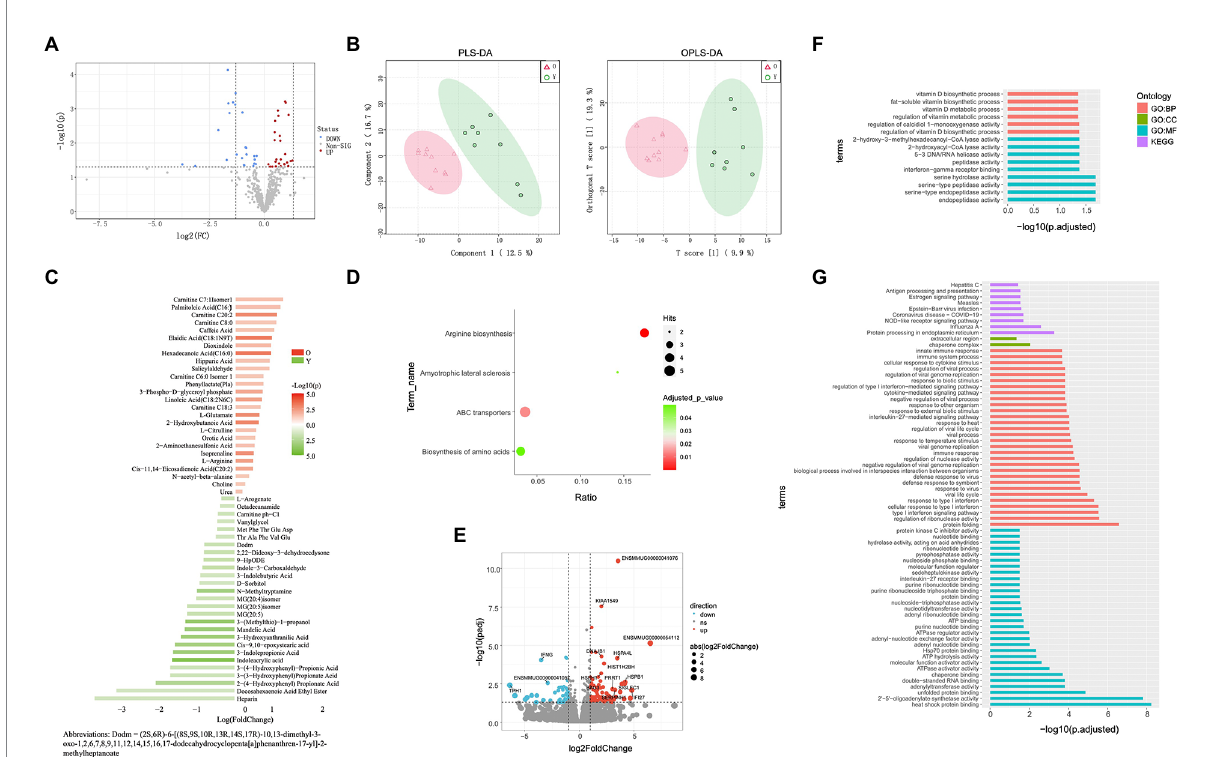
FIGURE 3 Blood metabolome and blood transcriptome analyses. (A) Volcano plots of metabolomes between young and old groups. (B) Partial least squares discriminant analysis (PLS-DA) and orthogonal partial least squares discriminant analysis (OPLS-DA) score plots based on metabolic profiles. (C) Differential abundance of blood metabolites in young and old groups (VIP ≥ 1, p < 0.05). (D) Enrichment analysis of differentially abundant pathways in young and old groups ( p < 0.05). (E) Volcano plots of DEGs in young and old groups (log fold-change ≥ 1, p < 0.05). (F) GO and KEGG pathway enrichment analyses of up-regulated DEGs in old group ( p < 0.05). (G) GO and KEGG pathway enrichment analyses of down-regulated DEGs of old group ( p <